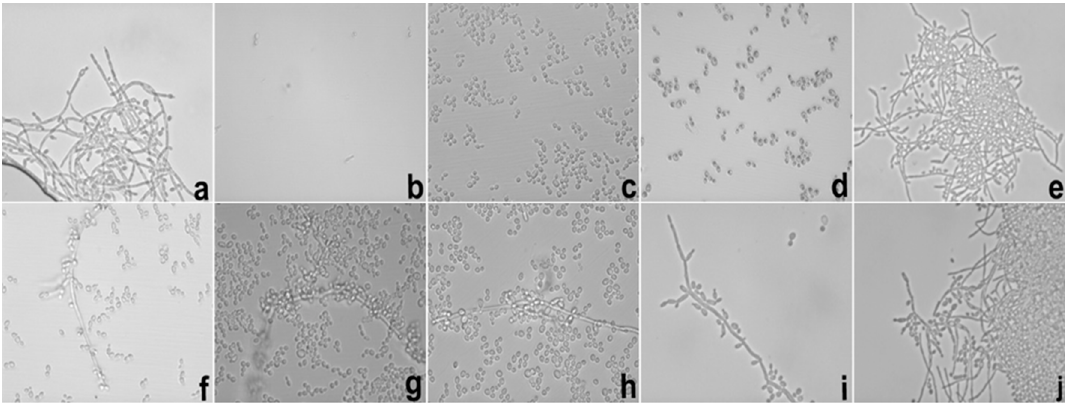
Figure 6. Photomicrography of 24 h of the hyphae inhibition test of C. albicans realized with E. Legend: ( a ) growth control; ( b ) amphotericin B 16 μ g/mL; ( c – j ) E from 1000 to 7.8 μ g/mL in descending order. E = Extract solution (without incorporation).